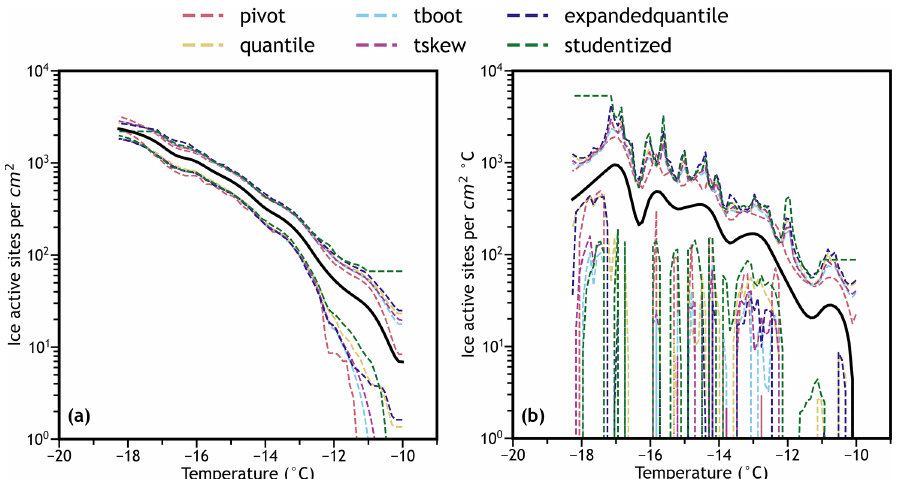
Figure 4. Comparison of methods to calculate confidence bands (shown as different-colored dashed lines) for (a) cumulative and (b) dif- ferential unaged volcanic ash n s spectra representing 91 droplets. Experimental spectra are shown in black. Most calculation techniques are in good agreement across the range of the cumulative spectrum, but all techniques except the studentized intervals (green dashed line) overestimate the variability in the differential spectra, resulting in confidence bands that are too wide across most of the